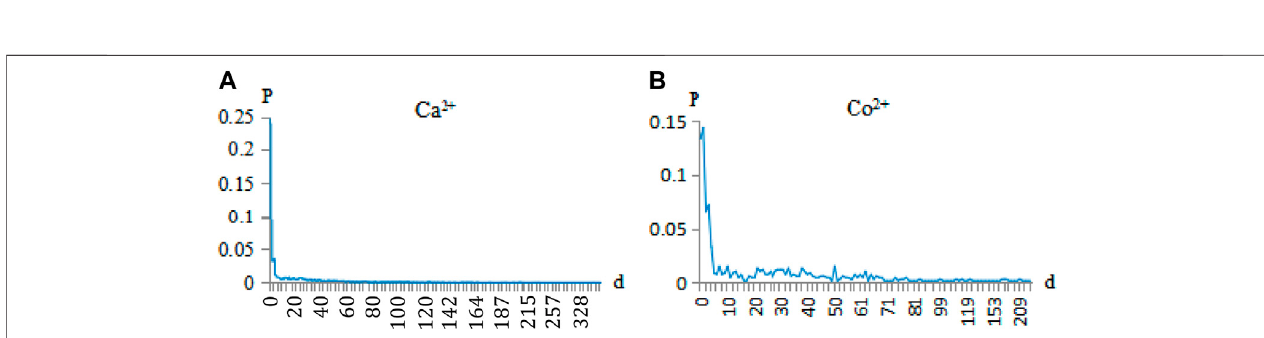
FIGURE 2 | Correlation probability of Ca 2+ and Co 2+ ligand-binding residues. Note: the abscissa d is the correlation of the binding residues (e.g., d (cid:1) 0 is the adjacent, d (cid:1) 1 is the secondary neighbor, d (cid:1) 2 is the thirdly neighbor). The ordinate p is the probability of correlation between the binding residues.